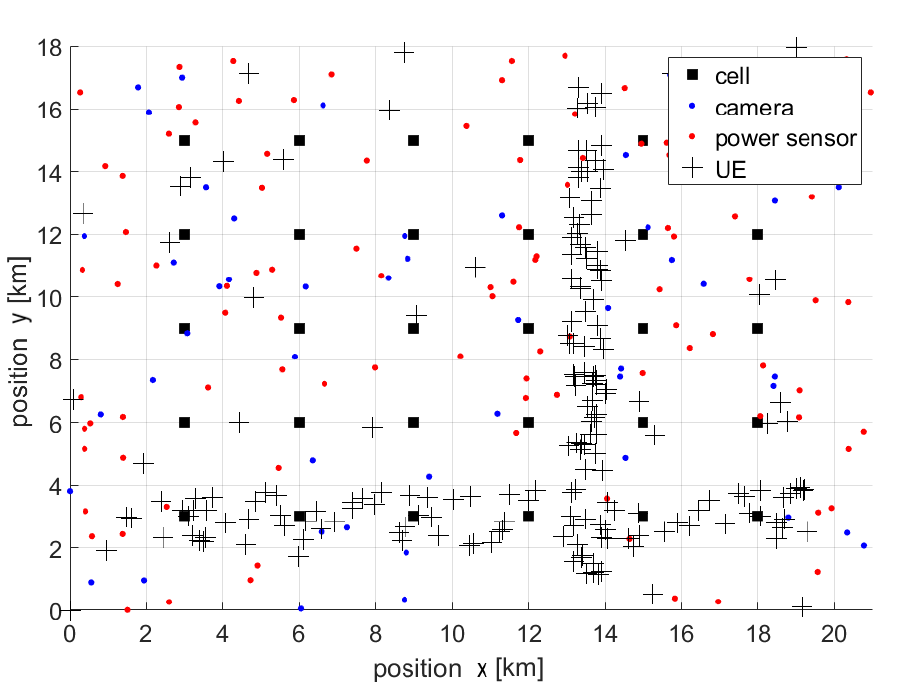
Figure 1. Example of a network